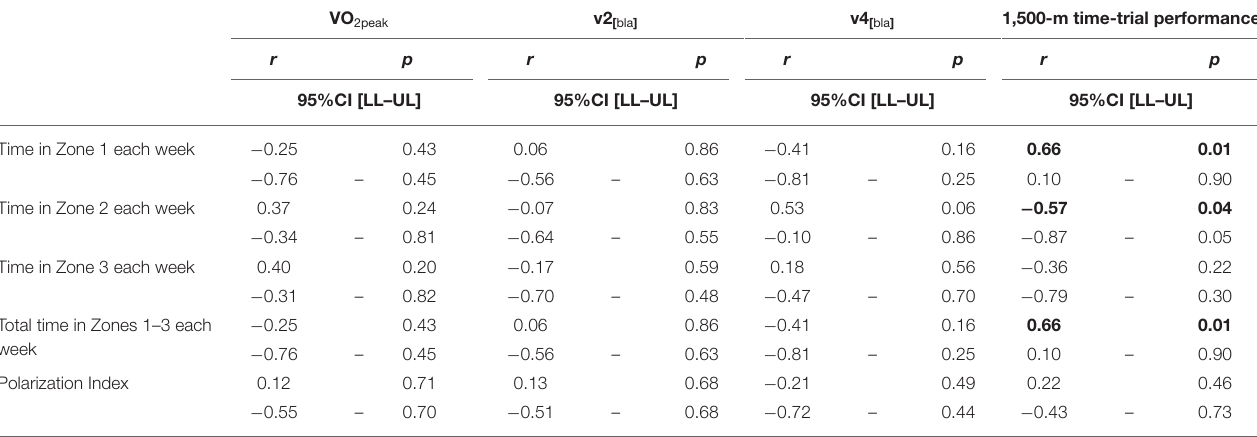
TABLE 6 | Correlations between the differences in physiological characteristics and parameters related to performance before and after each of the three training periods (PP1, PP2, CP), on the one hand, and the time spent in each training zone, total time spent in all three zones, and the Polarization Index, on the